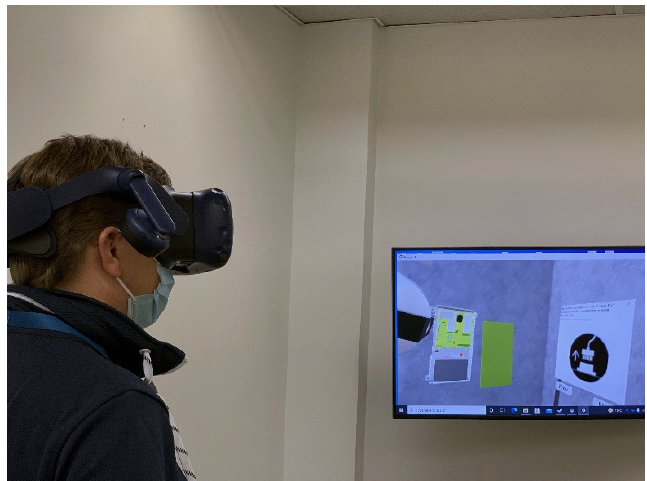
Figure 6. User test participant and VR view displayed in a